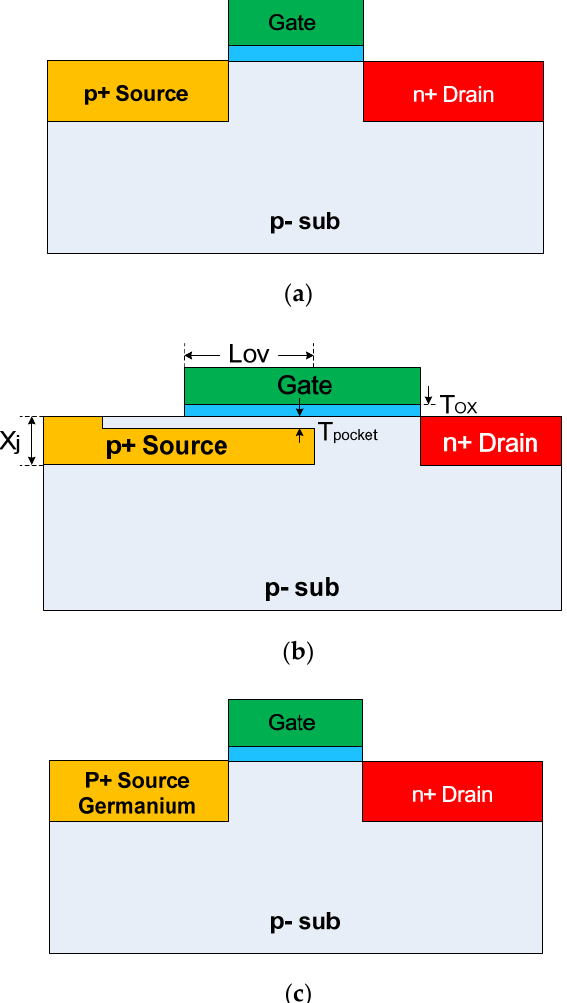
Figure 2. Cross-sectional views of ( a ) silicon-based point TFET, ( b ) line TFET and ( c ) Ge-source TFET used in this work (not to scale).